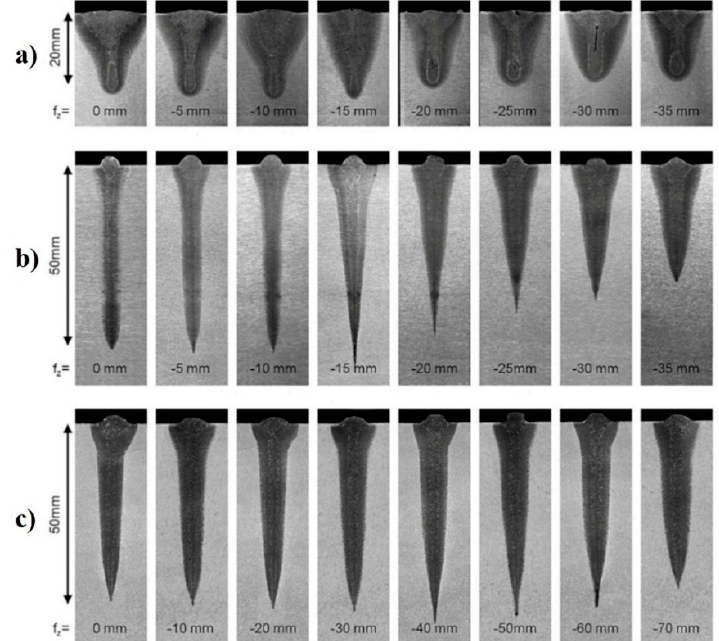
Figure 4. Comparison of cross section profiles using different welding processes ( a ) Laser welding (laser power is 16 kW, welding speed is 0.3 m/min, ambient pressure is 1000 mbar), ( b ) Laser welding under vacuum (laser power is 16 kW, welding speed is 0.3 m/min, ambient pressure is 10 − 1 mbar), ( c ) Electron beam welding (electron beam power is 16 kW, welding speed is 0.3 m/min, ambient pressure is 10 − 3 mbar). Reproduced with permission from [48], John Willey and Sons, 2015.